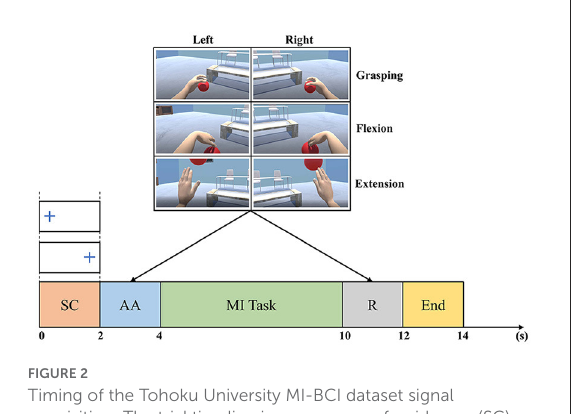
FIGURE2 Timing of the Tohoku University MI-BCI dataset signal acquisition. The trial timeline is a sequence of a side cue (SC), an animation (AA) of the MI task requested, a MI task performing, a visual reinforcement (R), and an end cue (Achanccaray et al.,